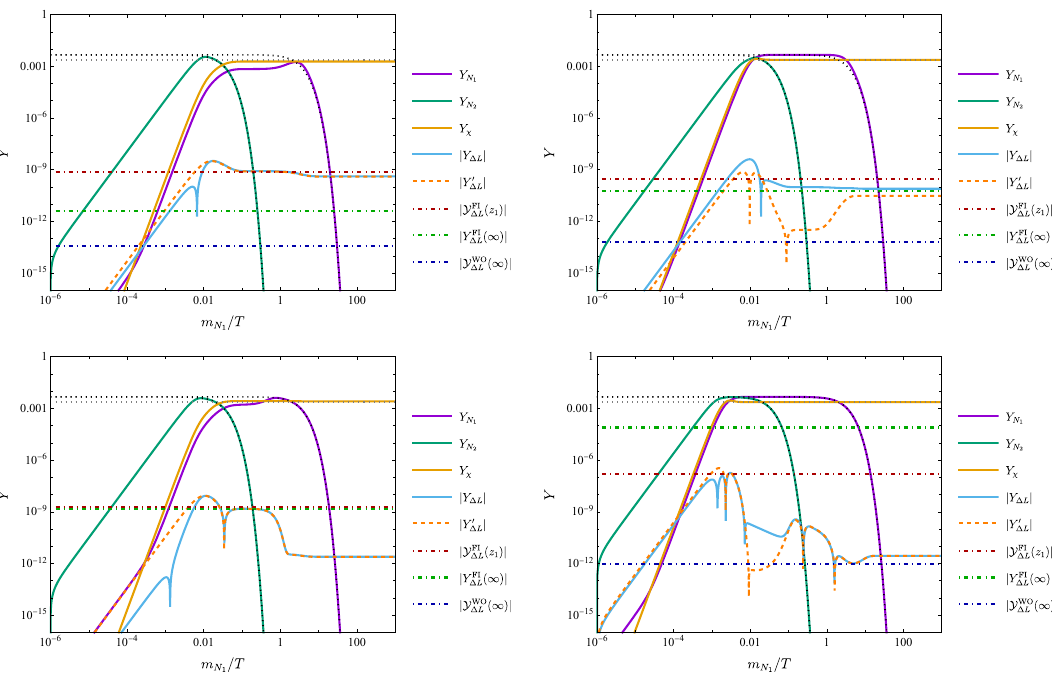
Figure 5 . The time evolution of the yields. In the top panels, the washout effect is weak and the asymmetry is produced by the freeze-in mechanism of the RH neutrino decays. The washout works well in the bottom panels. In the left panels, the N decay is the dominant production channels and 2 N 1 dominant in the right panels. The solid lines are numerical solutions of the Boltzmann equations [eqs. (4.3)–(4.6)]. The orange dashed line is evaluated by solving the Boltzmann equations of N and ∆ L with Y = Y eq . The dot-dashed dark red, dark green and dark blue lines are given by N 2 N 2 eqs. (4.7), (4.14) and (4.15),